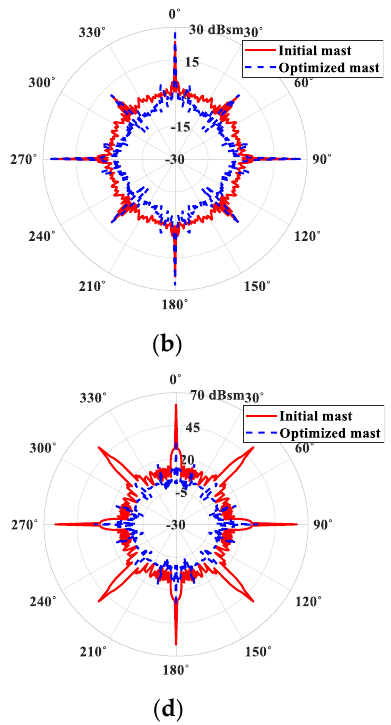
of 0°, ( b ) VV polarization at an elevation angle of 0°, ( c ) HH polarization at an elevation angle of 10°, ( d ) VV polarization